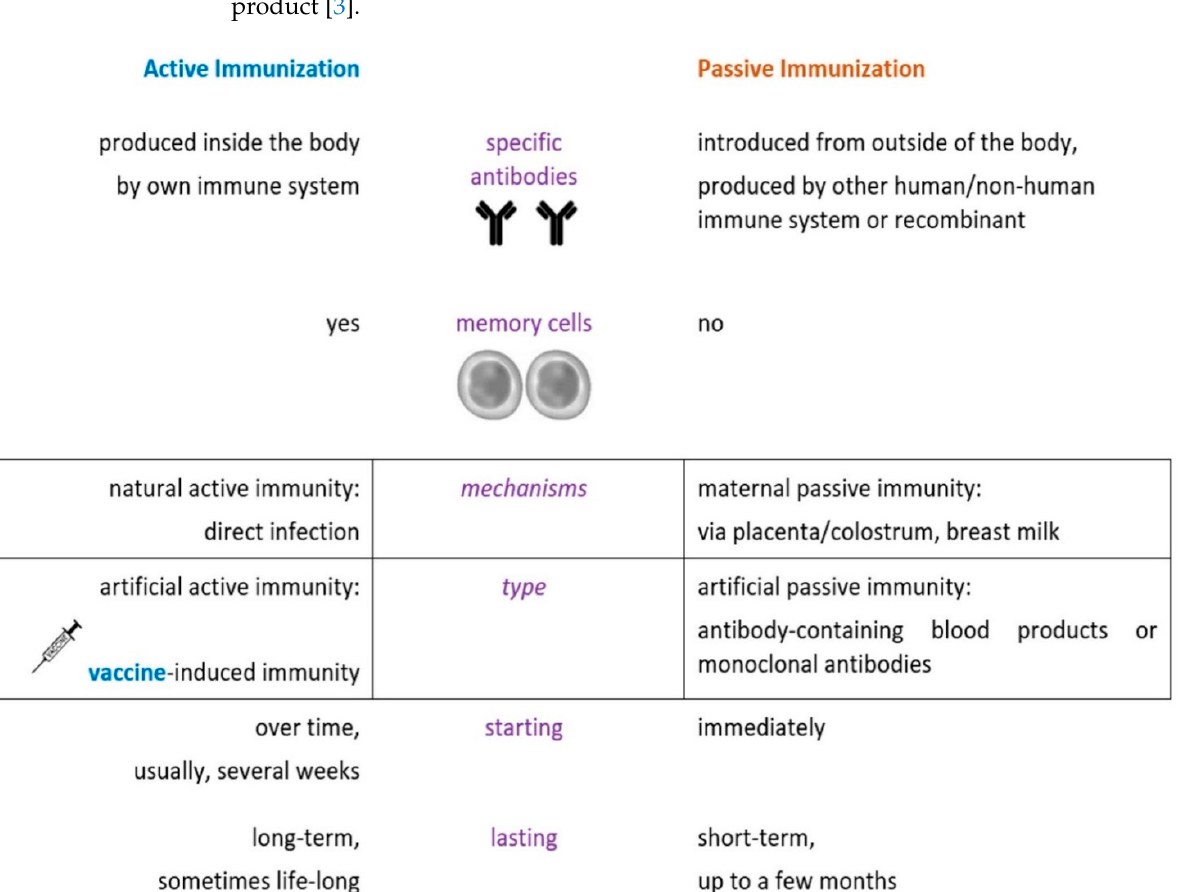
Figure 1. Position of vaccines as an active immunization strategy.